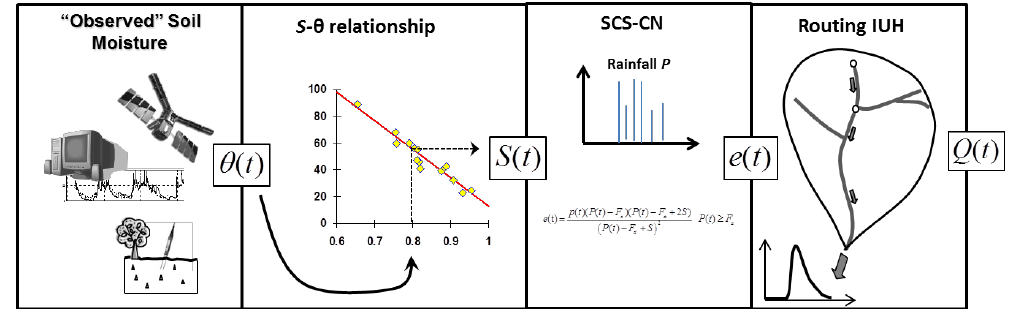
Figure 3: Structure of the Simplified Continuous RR Model (SCRRM). 3